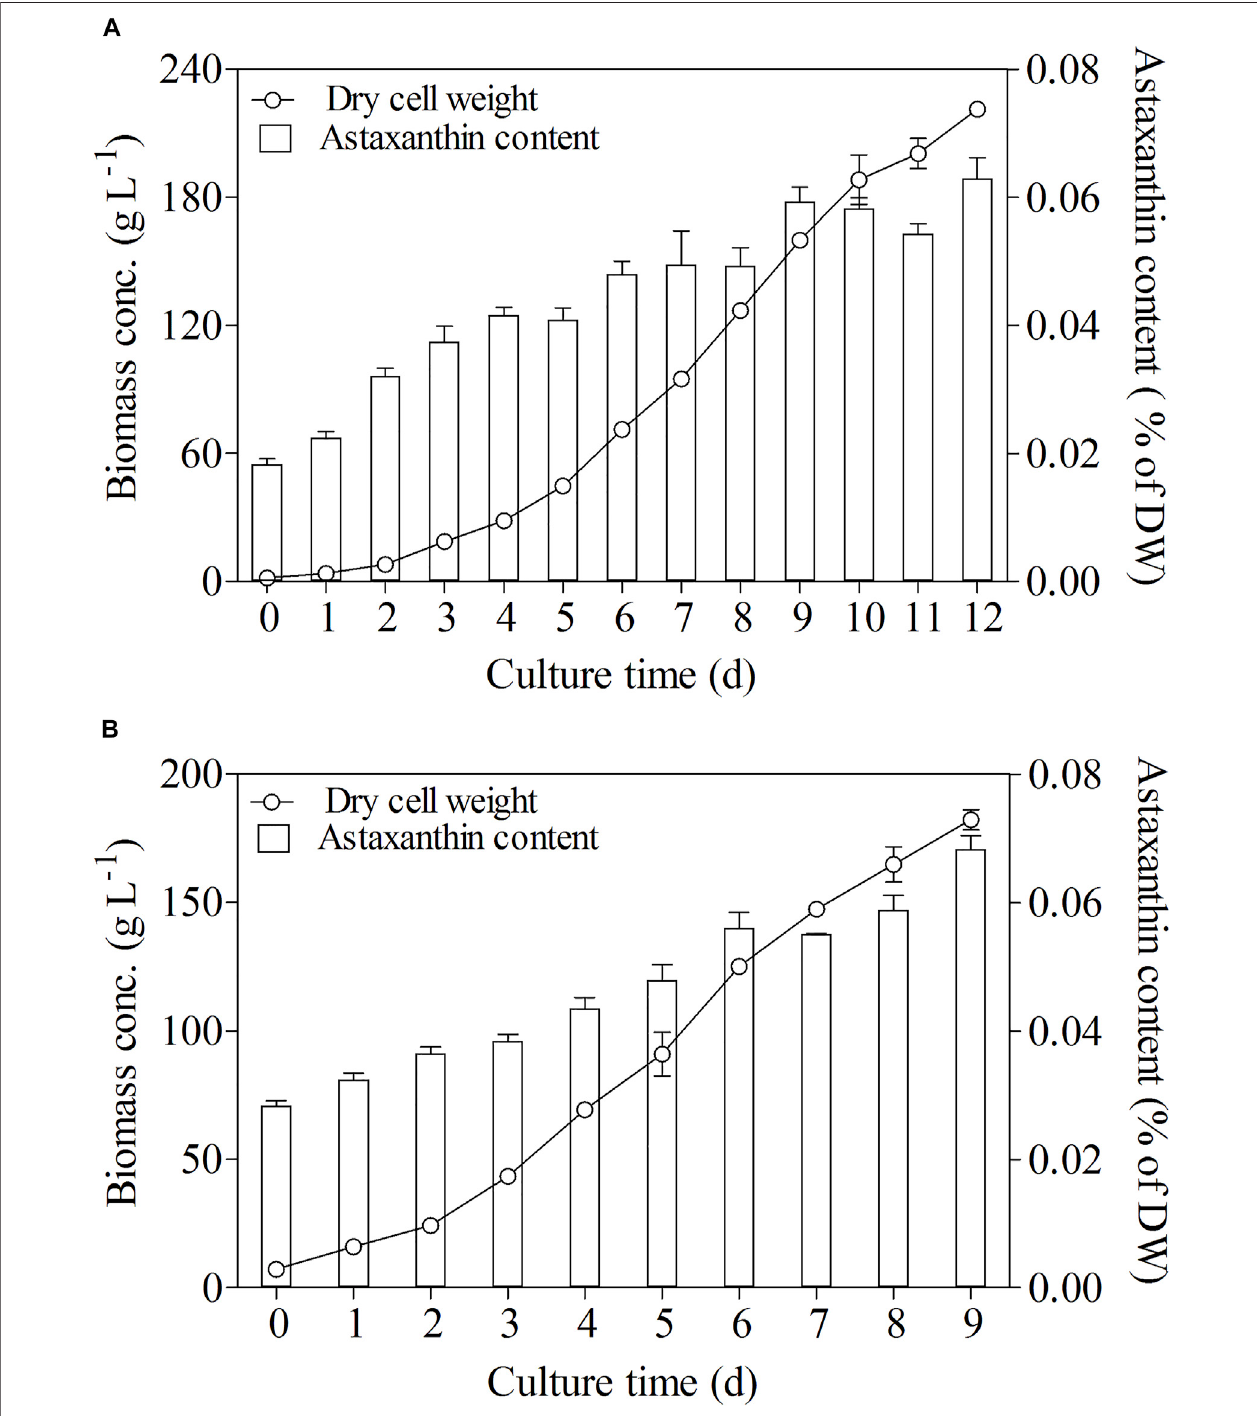
FIGURE 3 | Biomass and astaxanthin content in fed-batch fermentation of C. zo fi ngiensis in 7.5 L fermentors (A) and 500 L fermentors (B) with optimal cultural conditions. Data are mean values ±SD from triplicate measurements (n = 3).